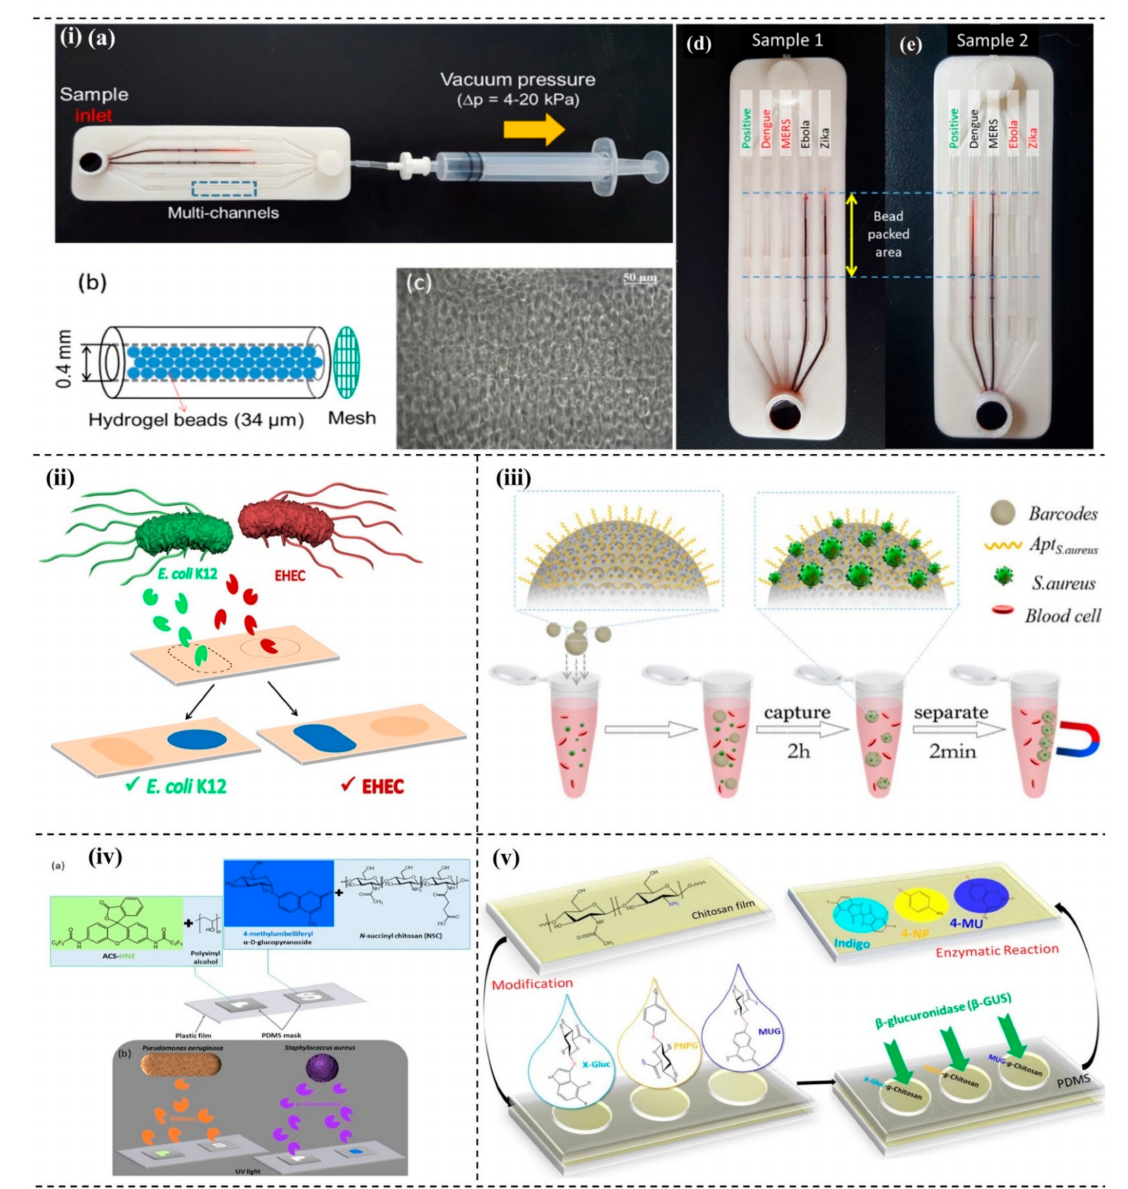
Figure 4. Hydrogel-based pathogen detection system. ( i ) Biosensor system using DNA hydrogels: ( a ) photograph of the kit, ( b ) bead—packed microchannel, ( c ) microscopic image of